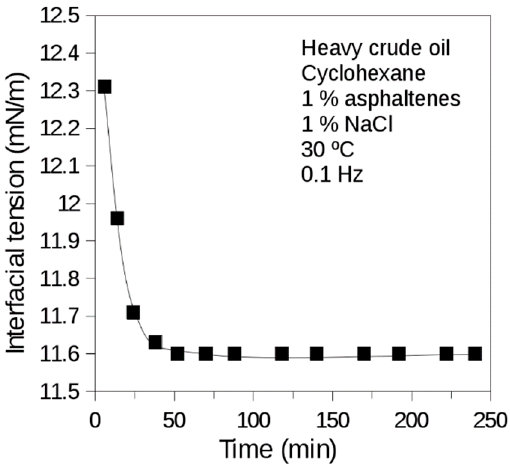
Figure 7. Dynamic interfacial tension of brine (1% NaCl)-heavy crude oil diluted in cyclohexane (1% asphaltenes) system. Heavy Venezuelan crude oil of 8° API with high asphaltene content (17 wt%) diluted in cyclohexane. T = 30 °C. Measurement made with the oscillating spinning drop equipment.